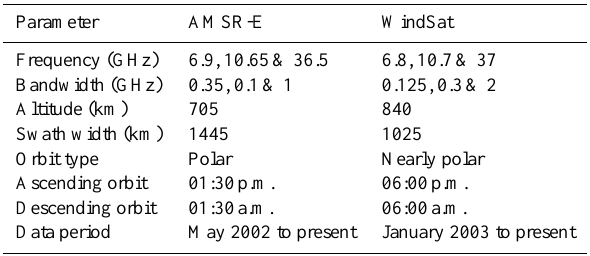
Table 2. Specifications of the AMSR-E and WindSat microwave sensors used in the soil moisture retrieval